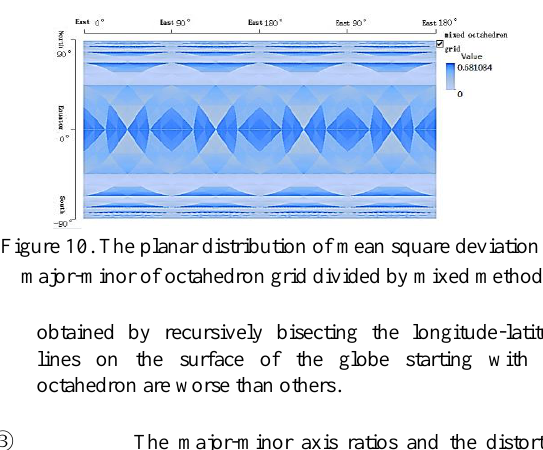
Figure 4. Mean square deviation of major-minor